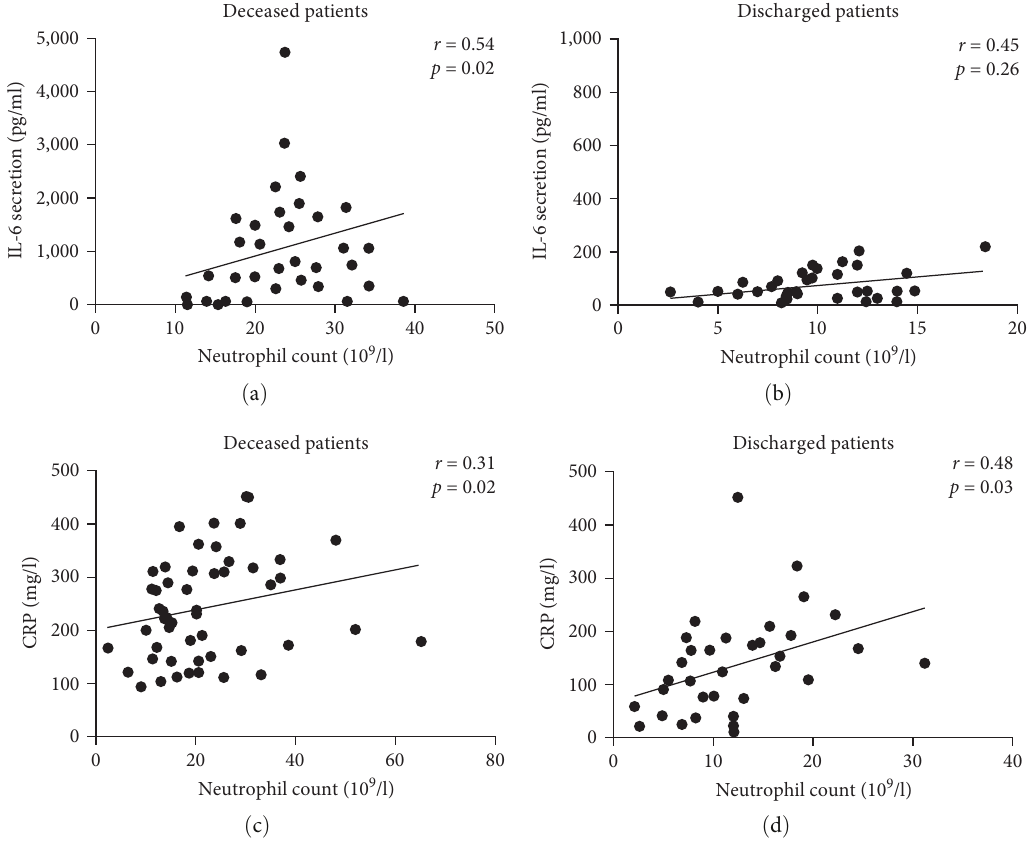
F IGURE 4: Correlation analysis between neutrophil, IL-6, and CRP in all deceased and discharged patients: (a) a positive signi fi cant correlation between IL-6 and neutrophil in deceased patients ( n =34, r =0.54, p ¼ 0 : 02); (b) there were no association between IL-6 and neutrophil in discharged patients ( n =33, r =0.45, p ¼ 0 : 25; (c) a positive signi fi cant correlation was obtained between CRP and neutrophil ( n =59, r = 0.31, p ¼ 0 : 02) in deceased patients and (d) in discharged ( n =35, r =0.48, p ¼ 0 : 03)